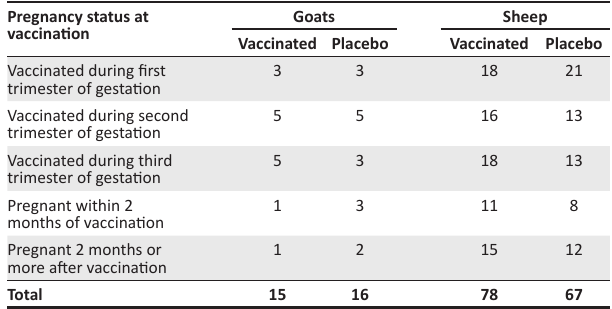
TABLE 2: Numbers of sheep and goats that gave birth in relation to time of vaccination using Onderstepoort Biological Products Rift Valley fever virus Clone 13